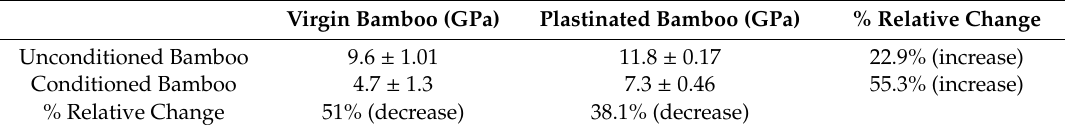
Table 3. Tensile sti ff ness comparison of di ff erent bamboo specimens tested.